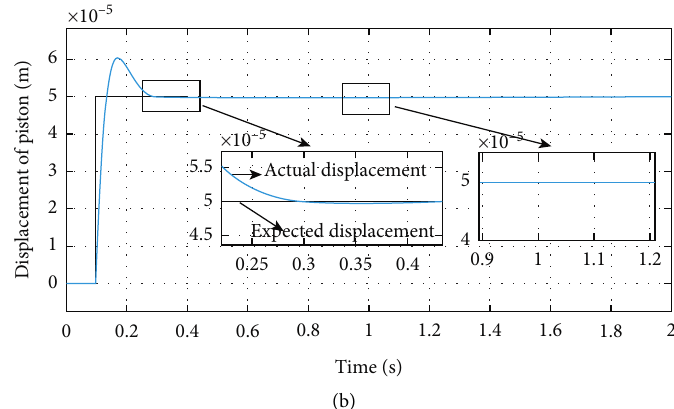
Figure 4: Piston displacement: (a) no adaptive friction compensation system added; (b) add adaptive friction compensation system.